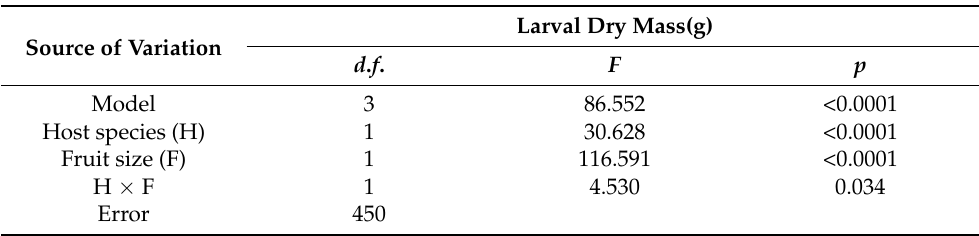
Table 3. Analyses of covariance of larval dry mass of two host species of C. styracis subjected to different fruit